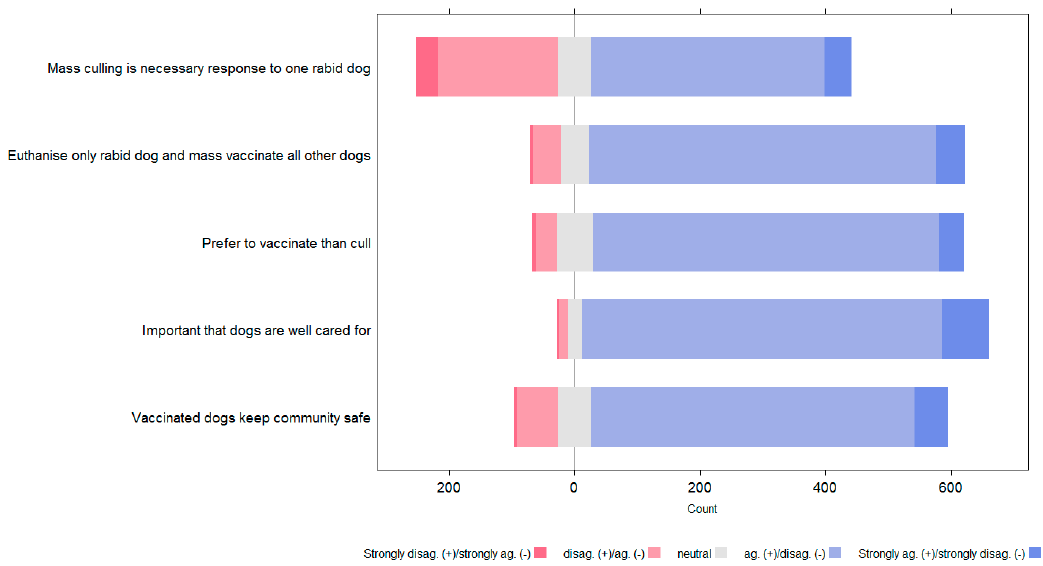
Figure 11. Level of non-owner agreement with attitude statements.